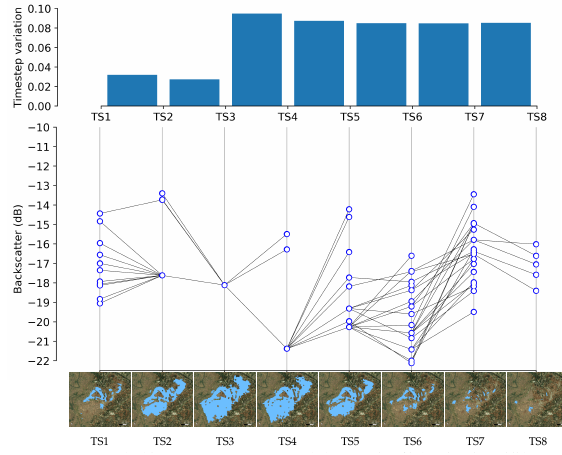
Figure6. Variation(top)betweenconsecutivetimesteps(TS),temporalprofile(graphinthemiddle) andpolygonevolution(bottom)ofonesingleentityintheIndianregionofinterest(Case2). Blue Figure 6. Variation (top) between consecutive timesteps (TS), temporal profile (graph in the middle) circlesinthegraphrepresentthepolygonsonthemapsinthebottomofthefigure. and polygon evolution (bottom) of one single entity in the Indian region of interest (Case 2). Blue flood,formingamultitudeofgraphs(32505graphsinCase2versus2192graphsinCase1). Becauseof 148 theobject-basedapproach,anupscalinginareadoesnotnecessarilyimplyanincreaseofcalculation 149 circles in the graph represent the polygons on the maps in the bottom of the figure. time. However,thecalculationtimecanbelinkedtothedegreeofdispersion. Adispersedfloodwill 150 resultinmoreentities,meaningmoregraphsandahighercalculationtime. TheMozambiqueflood 151 reachesaverylargeextentatthethirdtimestep,combiningpreviousseparateentitiesinonebigentity 152 (onegraph). 153 InFigure6,thetemporalprofileofoneentityisdepicted(anadditionalexamplecanbefoundinthe 154 supplementarymaterials). Eachnodeinthegraphrepresentsa(flood)waterpolygon,whileanedge 155 depictsaspatialoverlapbetweentheconnectingnodes. Inthisway, awaterbodyisdescribedby 156 the evolution of the number of polygons and their backscatter over the timesteps. In Figure 7 the 157 last timestep of Figure 6 is shown in detail. Five polygons are present at this timestep (TS8) with 158